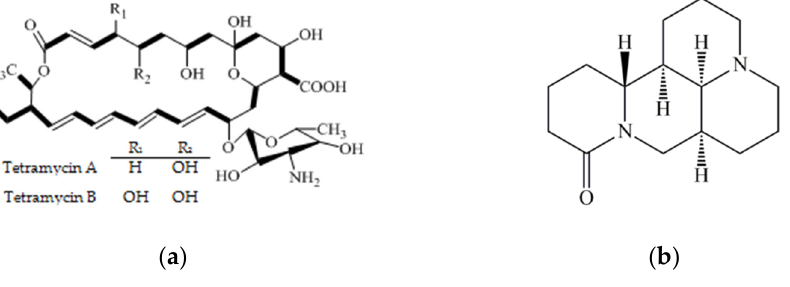
Figure 1. The chemical structures of tetramycin ( a ) and matrine ( b ).